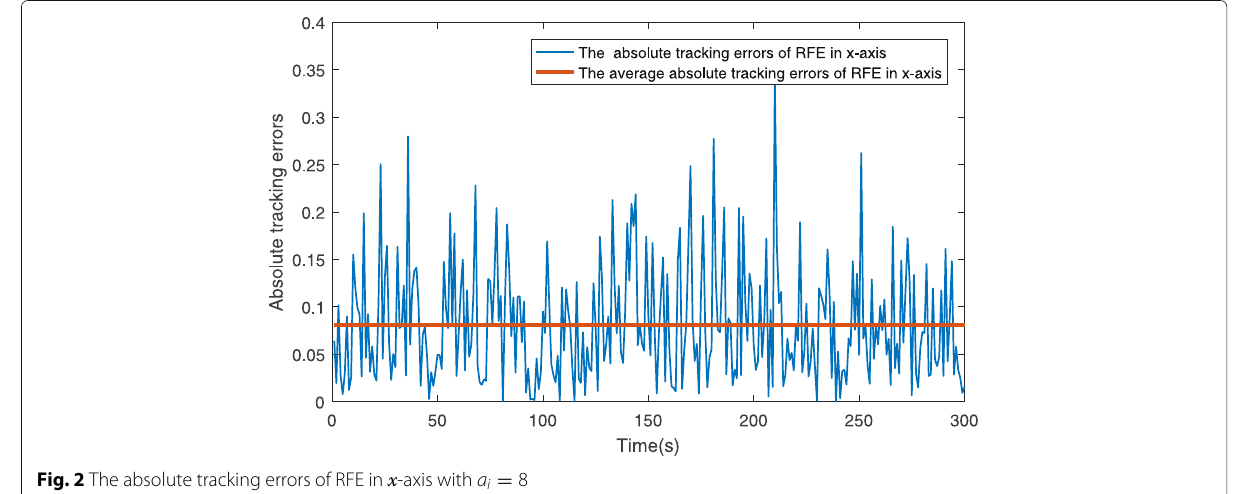
Fig. 2 The absolute tracking errors of RFE in x -axis with a i = 8